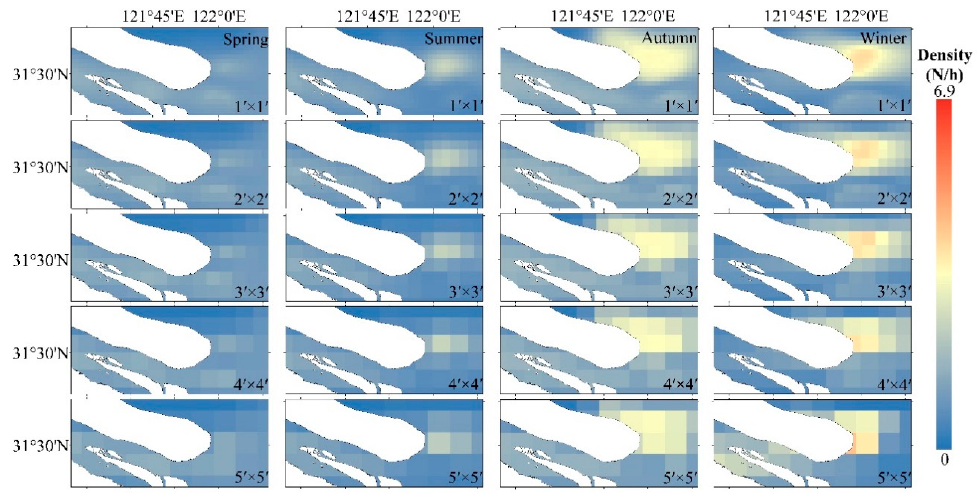
Figure 6. Spatial distribution of Coilia nasus predicted using interpolated environmental variables from different spatial resolutions in 2013 in the Changjiang River estuary.